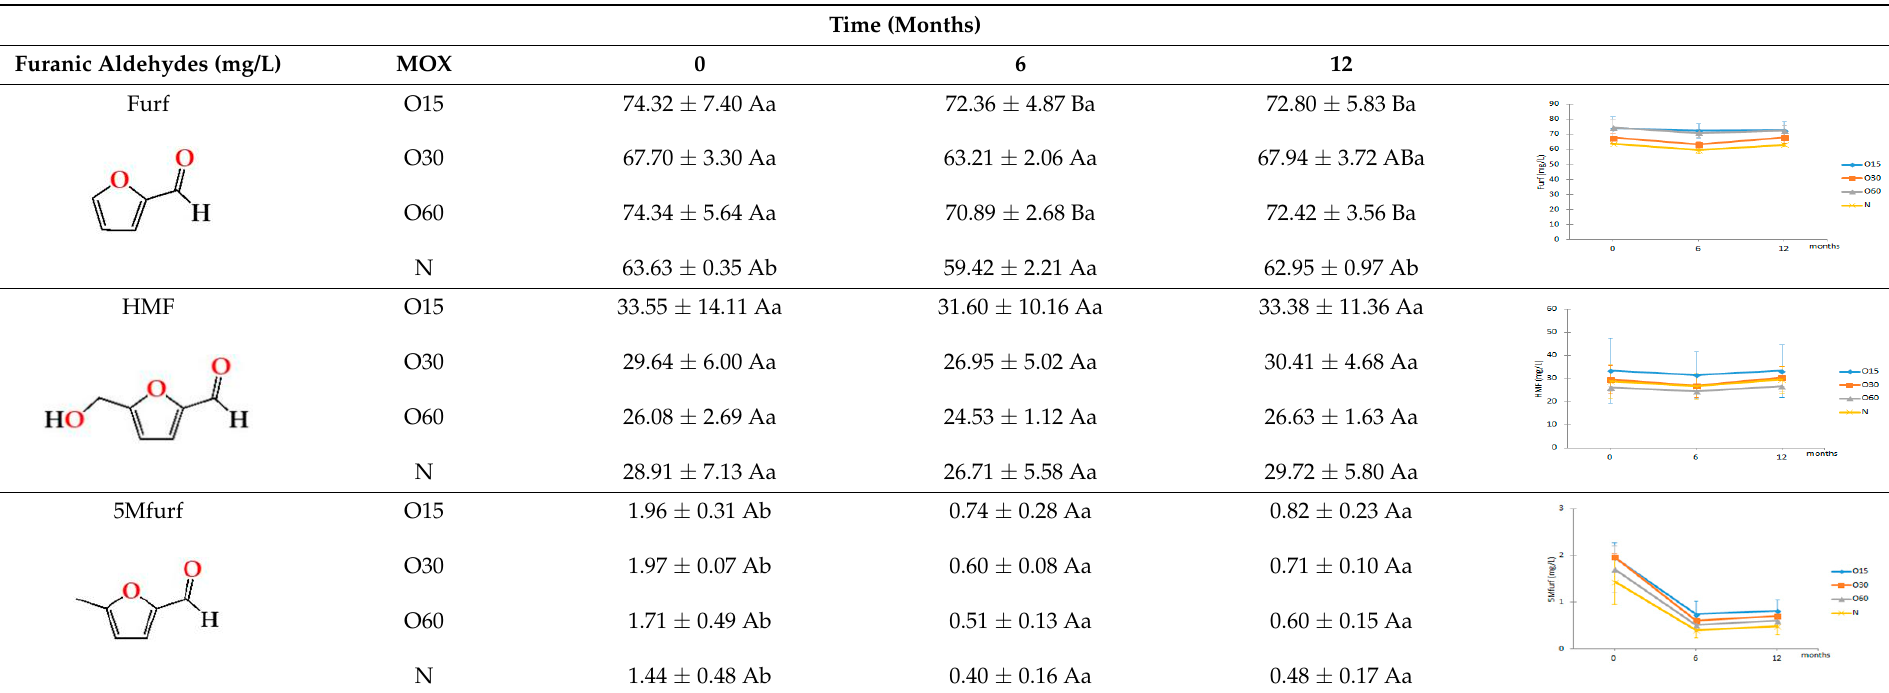
Results are expressed as mean values ± standard deviation ( n = 4). For compound: different uppercase letters (A, B) in the same column denote significant differences between ageing modalities in each storage time by Tukey’s test ( p < 0.05); different lowercase letters (a, b) in the same row denote significant differences between storage times for each ageing modality by Tukey’s test ( p < 0.05). Furf—furfural; HMF—5-hydroxymethyl- furfural; 5Mfurf—5-methylfurfural.